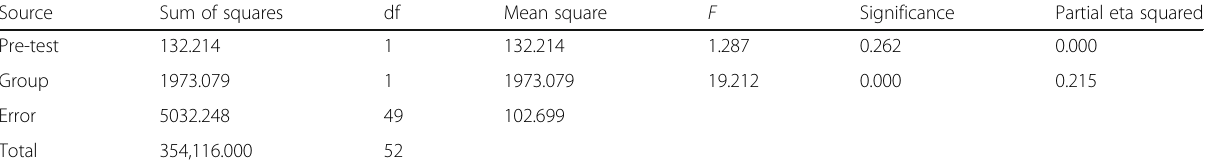
Table 3 Analysis of covariance result of total social skill assessment in two intervention groups Source Sum of squares df Mean square F